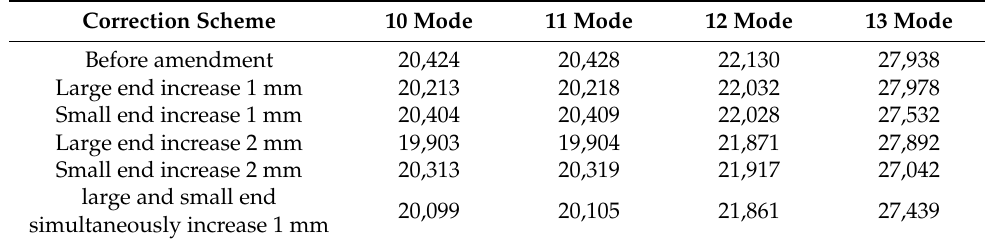
Table 4. The change of the natural frequency after increasing different lengths of the horn (Hz).